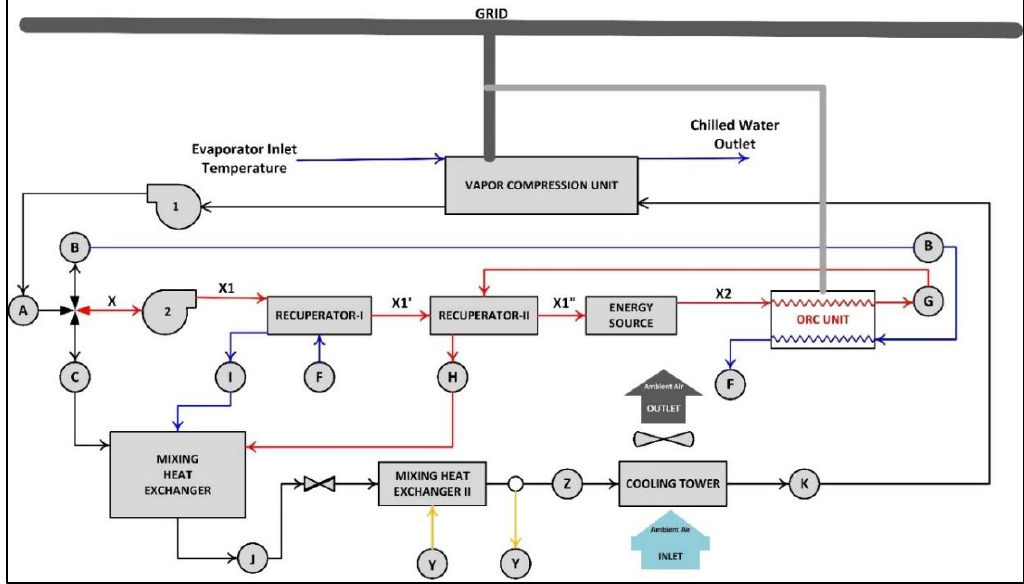
Figure 2. Schematic of the proposed scheme.